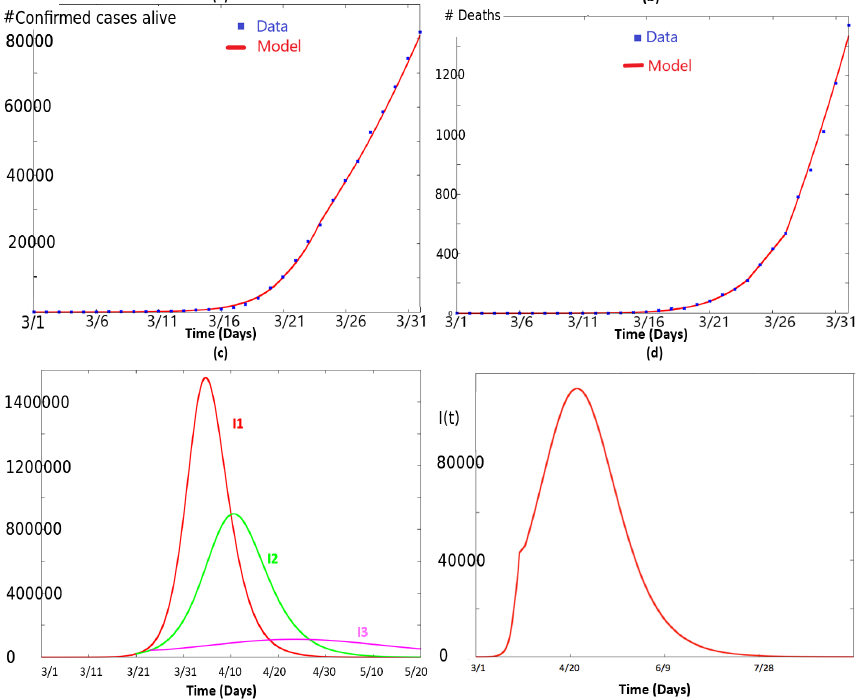
Figure 1. This figure illustrates the simulation of system (2) and how it fits the data. In ( a ), we have plotted the quantity 0.2 × ( I + R ) as a function of time in red. The blue dots correspond to the data (cid:82) t d ( s ) I ( s ) ds , which represents retrieved from [20]. Analogously, in ( b ), we have plotted the quantity 0 the total number of deaths according with the model, as a function of time in red. The blue dots correspond to the data retrieved from [20]. In ( c ), we have illustrated the quantity I ( t ) corresponding to different values of k ( t ) , d ( t ) : the curve I 1 ( t ) in red corresponds to the simulation of (2) with k ( t ) = k 1 and d ( t ) = d 1 for all time. The curve I 2 ( t ) in green corresponds to the simulation of (2) with k ( t ) = k 1 and d ( t ) = d 1 for 0 ≤ t ≤ 21, and k ( t ) = k 2 and d ( t ) = d 2 for t ≥ 21. The curve I 3 ( t ) in pink corresponds to the simulation of (2) with k ( t ) as given in (3), i.e., k ( t ) = k i and d ( t ) = d i , t ∈ [ t i − 1 , t i ) , i ∈ { 1,...,4 } with t 0 = 0, t 1 = 21, t 2 = 24, t 3 = 27, t 4 = 32. It illustrates how the health policies flatten the curve. In ( d ), we have again plotted the solution I ( t ) for k ( t ) as in (3), for a longer